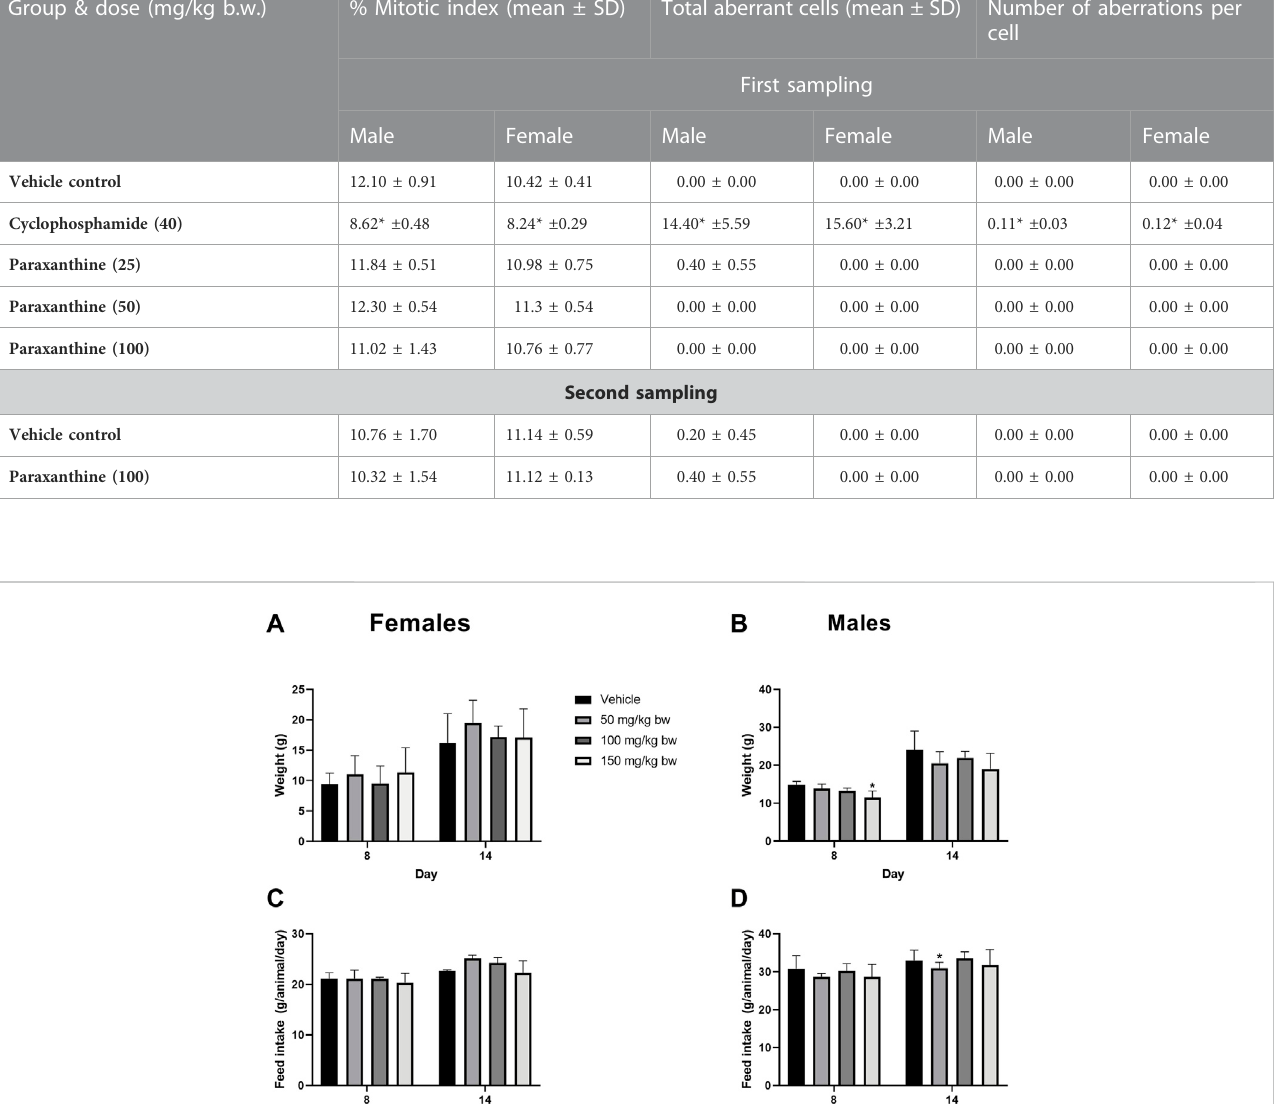
TABLE 1 Summary results of the bone marrow chromosome aberration test. Statistically signi fi cant compared to the control group at p < 0.05 (*) . Group & dose (mg/kg b.w.)